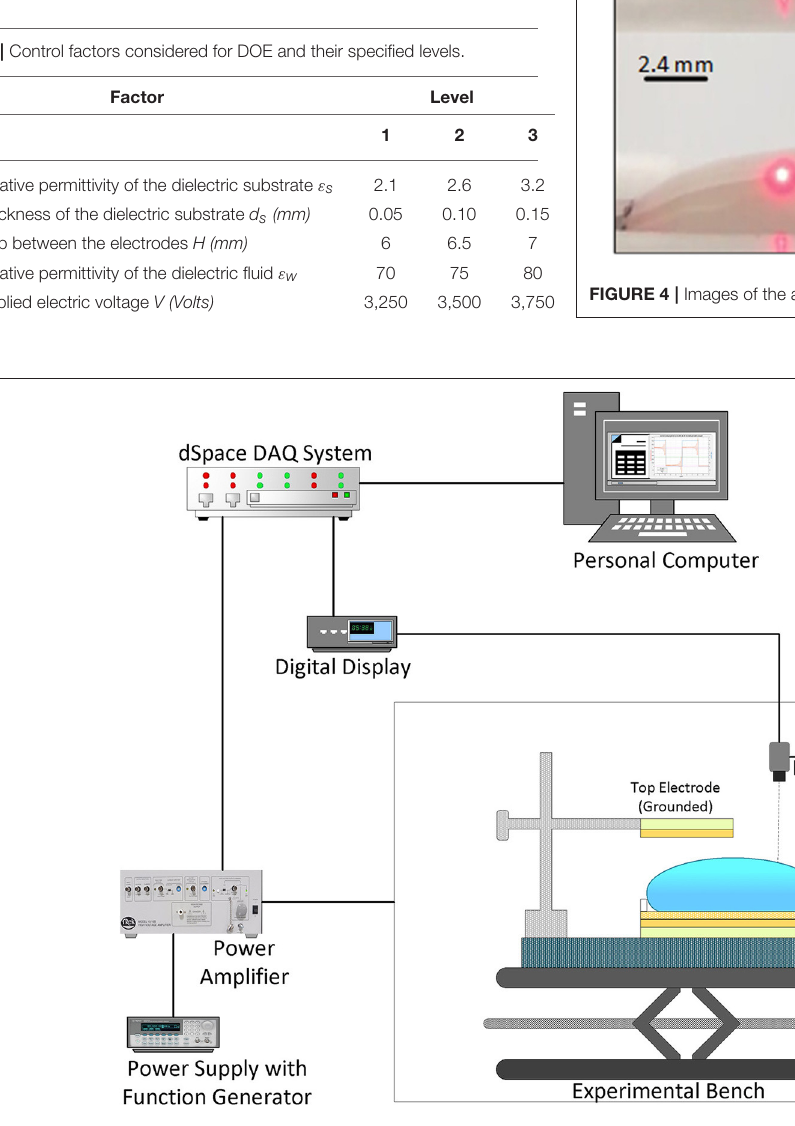
FIGURE 3 | Schematic of the detailed experimental